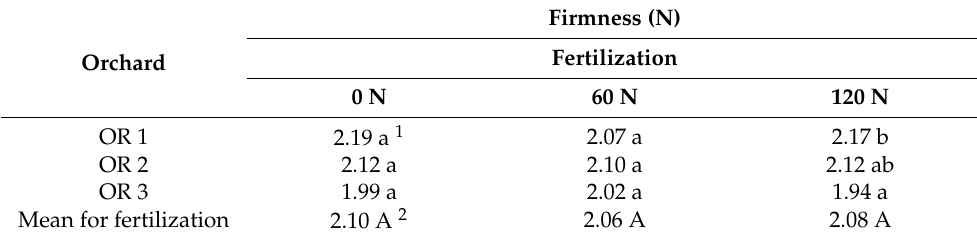
Table 7. Firmness of sour cherry fruit cv. Łut ó wka in